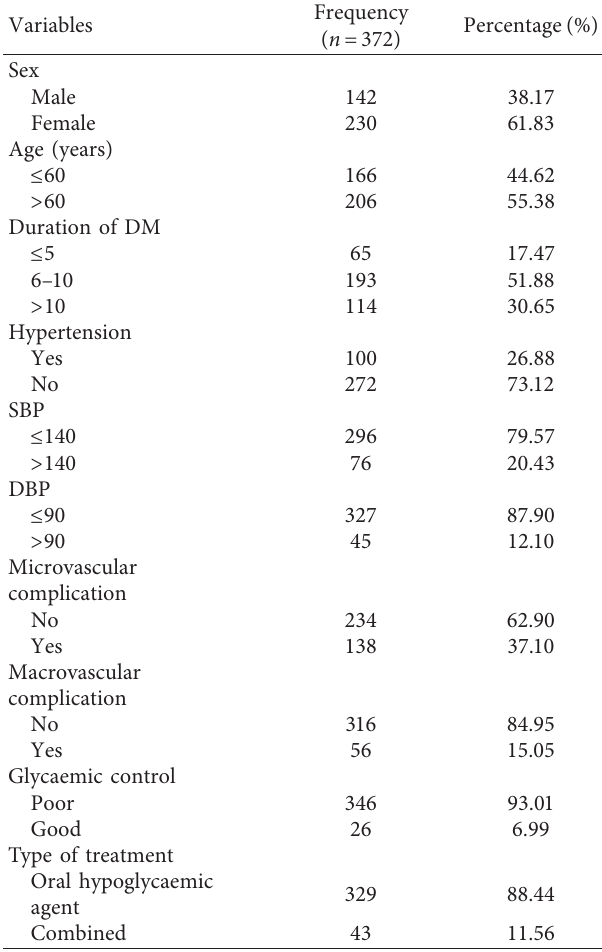
Table 1: Sociodemographic and clinical characteristics of T2DM patients at UGCSH, Northwest Ethiopia, 2019 ( n �